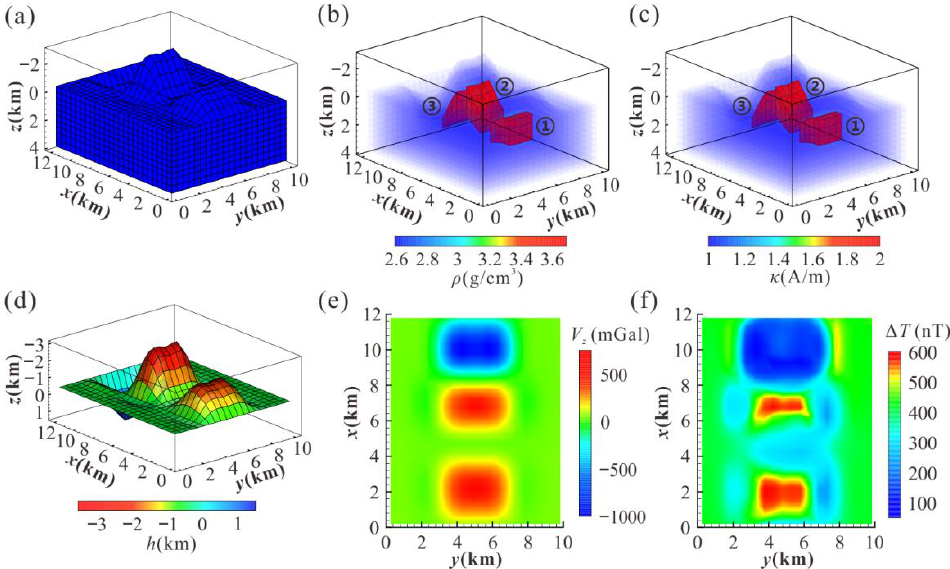
Figure 16. ( a ) Model division; ( b , c ) real density/magnetization model; ( d ) topographic relief; ( e , f ) observation data.